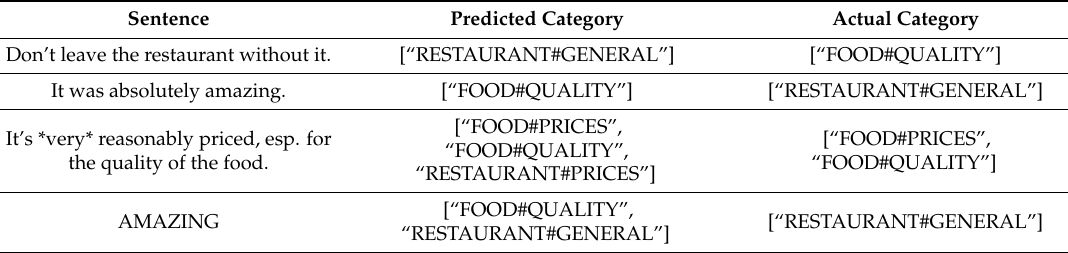
Table 11. Ambiguity due to presence of personal